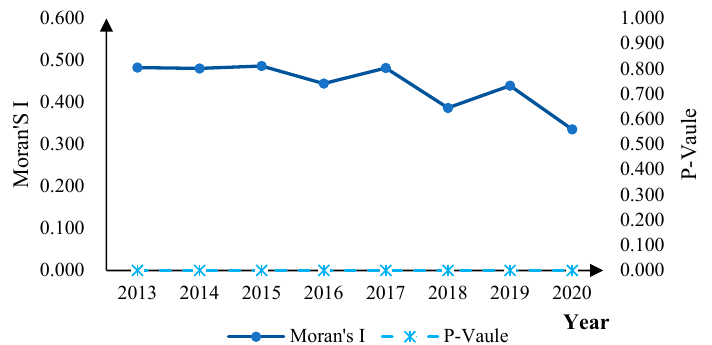
Figure 2. Global Moran’s I of air pollution